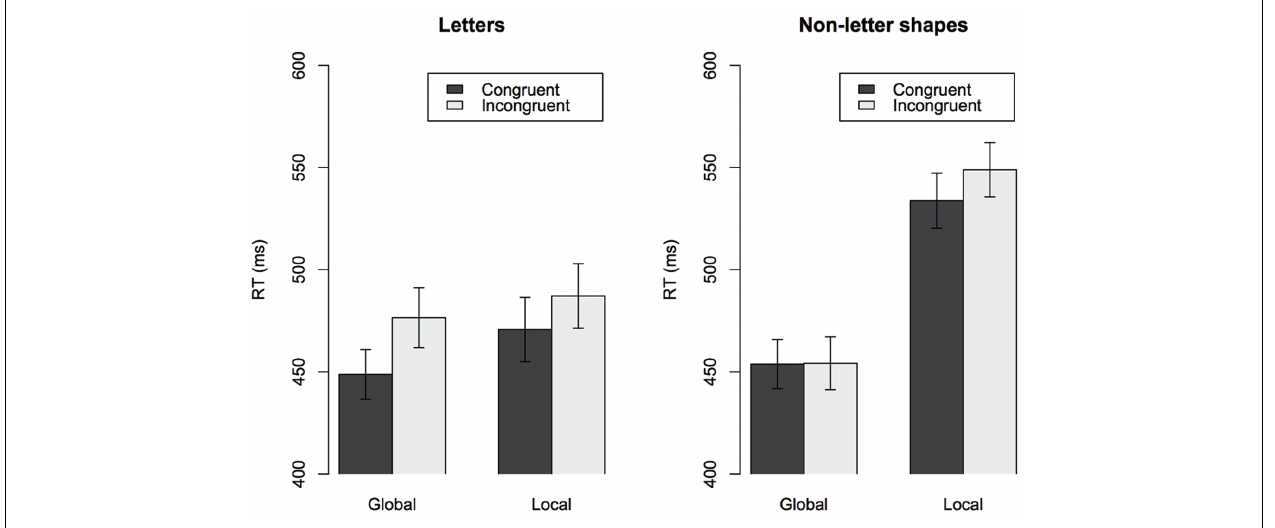
FIGURE 2 | Mean RT in ms for letter stimuli (left side) and non-letter stimuli (right side) for congruent and incongruent trials in the local and global trial